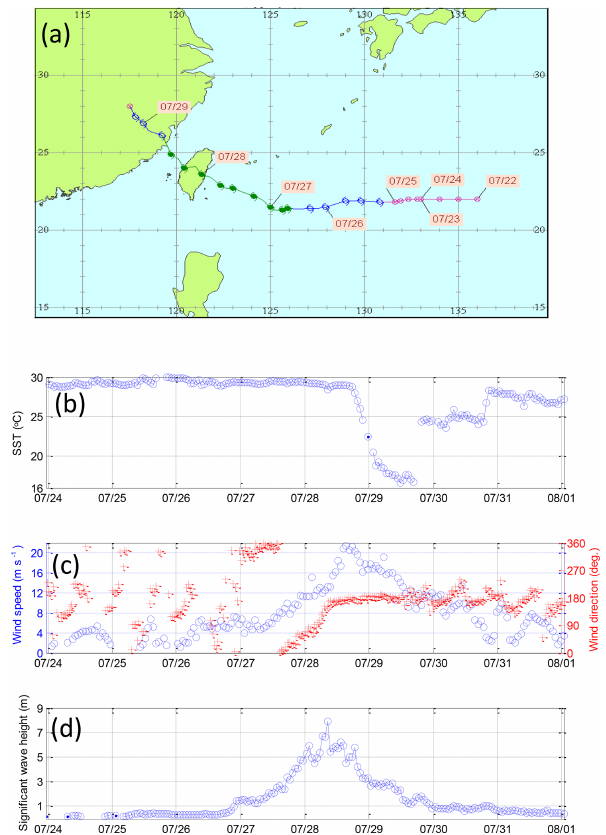
Figure 3. The significant SST drop event after the passage of Ty- phoon Fungwong in 2008. (a) The typhoon track, (b) SST, (c) wind speed and direction, and (d) significant wave height. The data were observed by a data buoy in the Longdong coastal waters of north- eastern Taiwan.